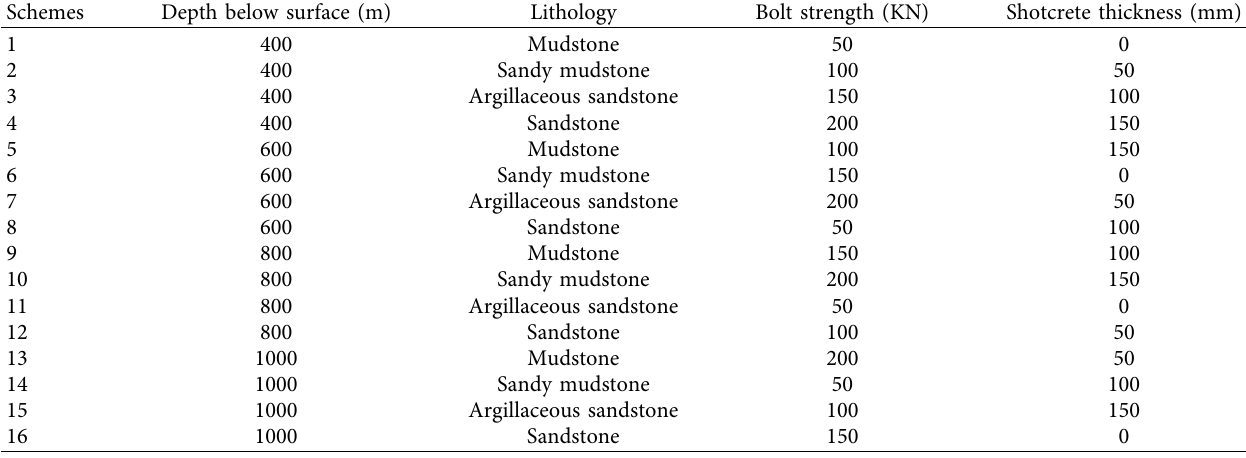
Table 6: Scheme on isotropic experiment design.